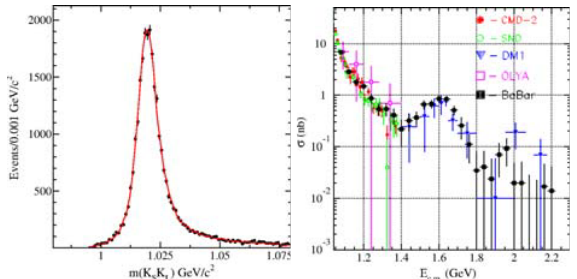
Figure 5. The e + e − → K 0 S K 0 L hadronic cross section at B A B AR . In the left plot the K 0 S K 0 L in the Φ (1020) is shown. The right plot contains the comparison of the K 0 S K 0 L cross section from the data of all relevant experiments.